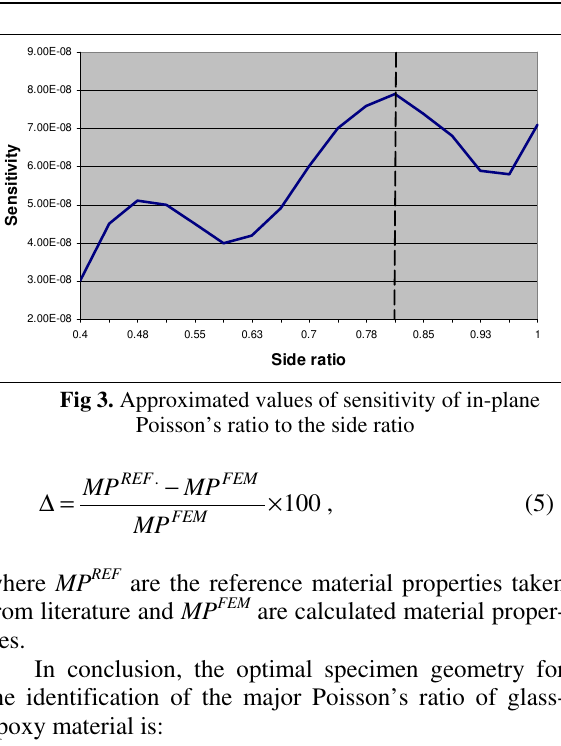
Table 3. Identified material properties of glass-epoxy (square specimen)